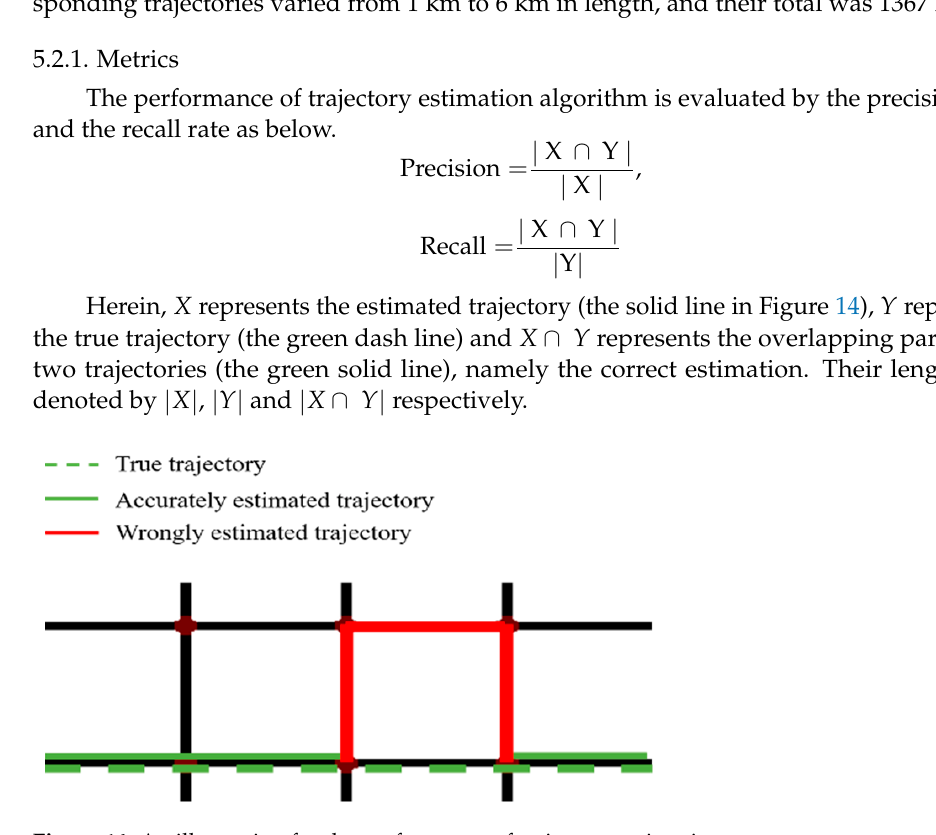
Figure 15. Effects of the 𝜃 -value on the fingerprinting performance.